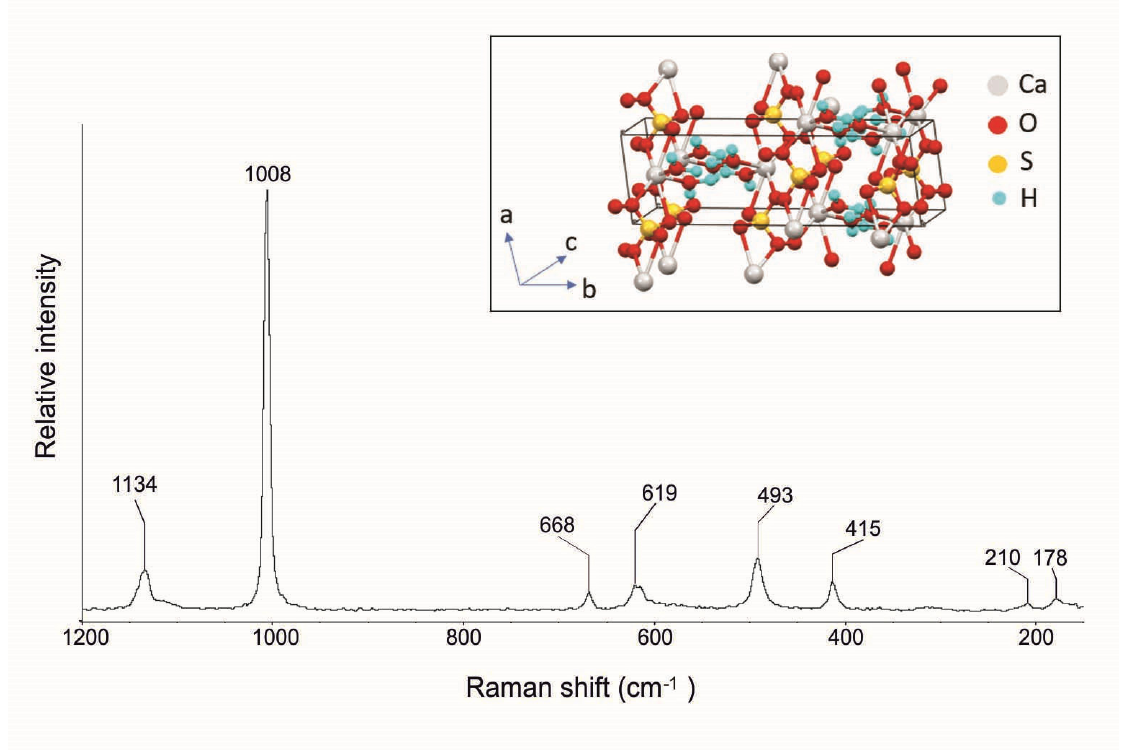
Figure 10. Raman spectrum of gypsum crystals from the Mastricarro Barite Mine (Catanzaro, south- ern Italy). In the insert is the structure of the gypsum [45].